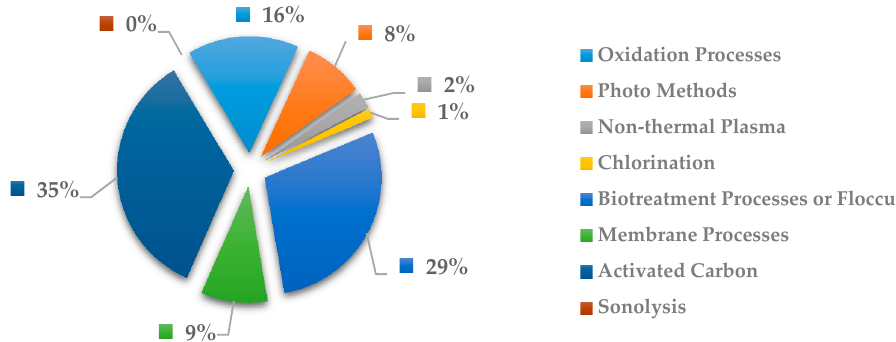
Figure 31. Percentage of scientific articles worldwide regarding wastewater treatments of respiratory system drugs between 1998 and 2020. Data collected in Scopus database by using wastewater or water as keywords and English as a language limitation.